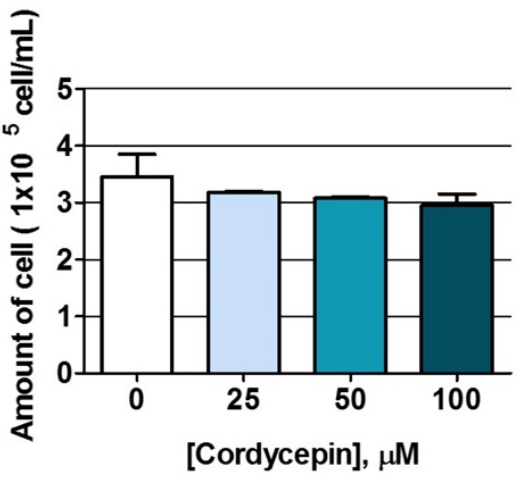
Figure 4. The effects of cordycepin on NK cell proliferation. The amount of NK cells was examined after a 24-hour cordycepin treatment at concentrations of 0, 25, 50, and 100 µ M using trypan blue exclusion assay.